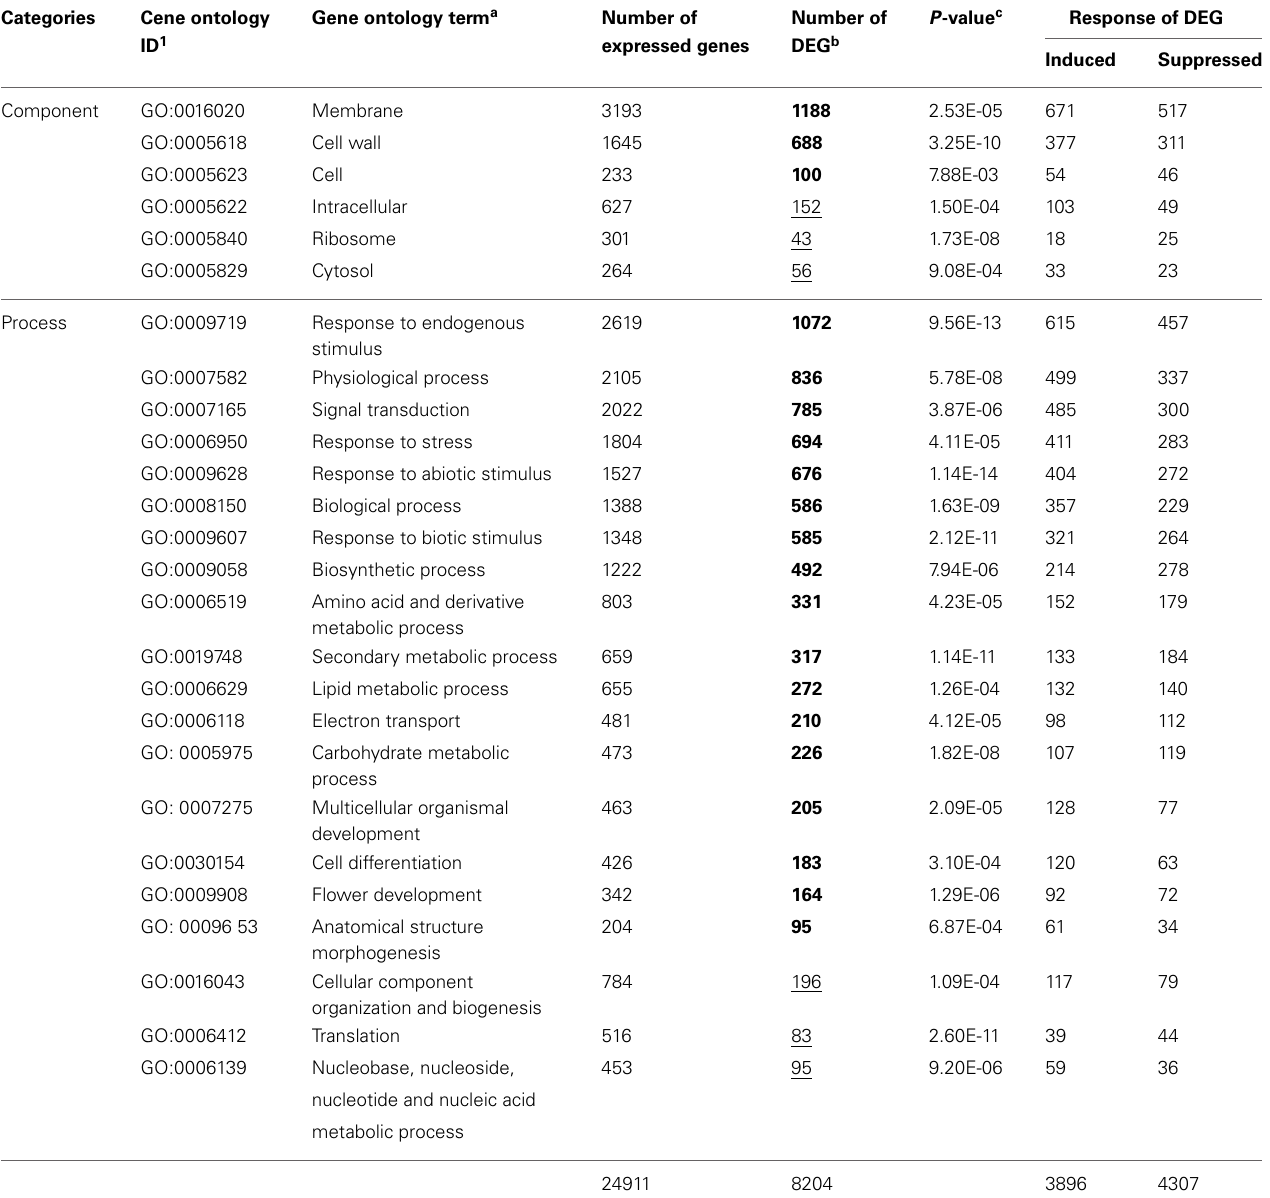
Table 1 | Numbers of DEGs in gene ontology groups overrepresented or underrepresented in RGSV-infected